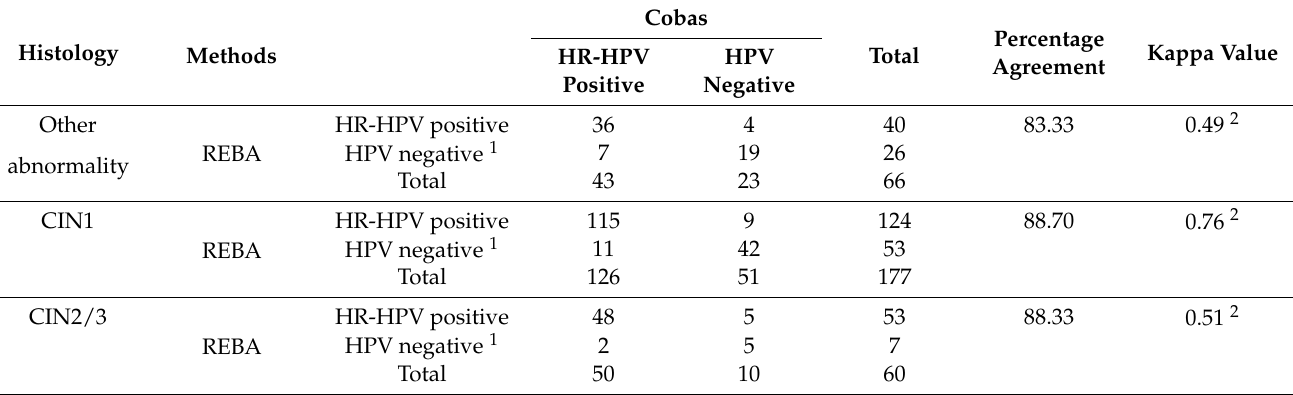
Table 3. HR-HPV detection rate comparison between the cobas ® 4800 and REBA-HIV-ID ® assays, stratified